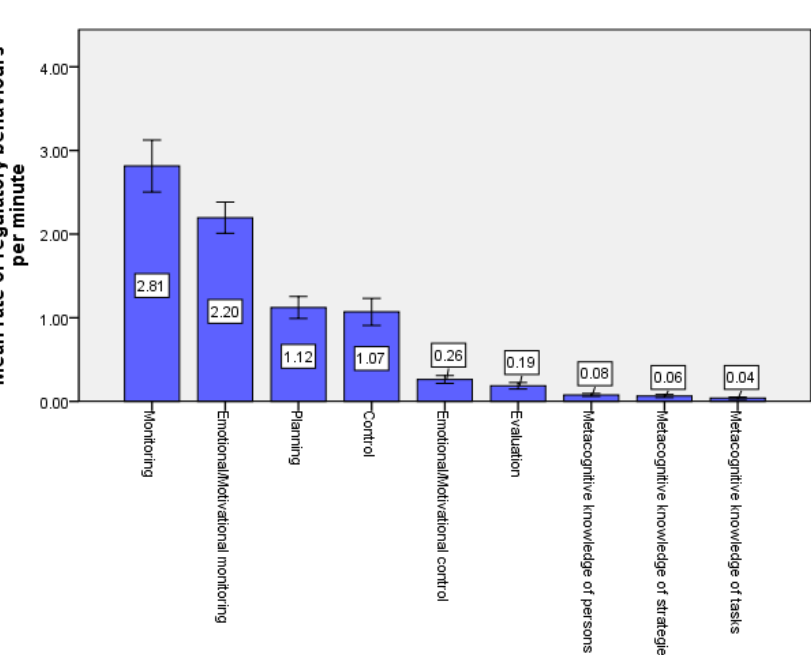
Figure 2. Bar graph of mean rates per specific regulatory behaviour during musical